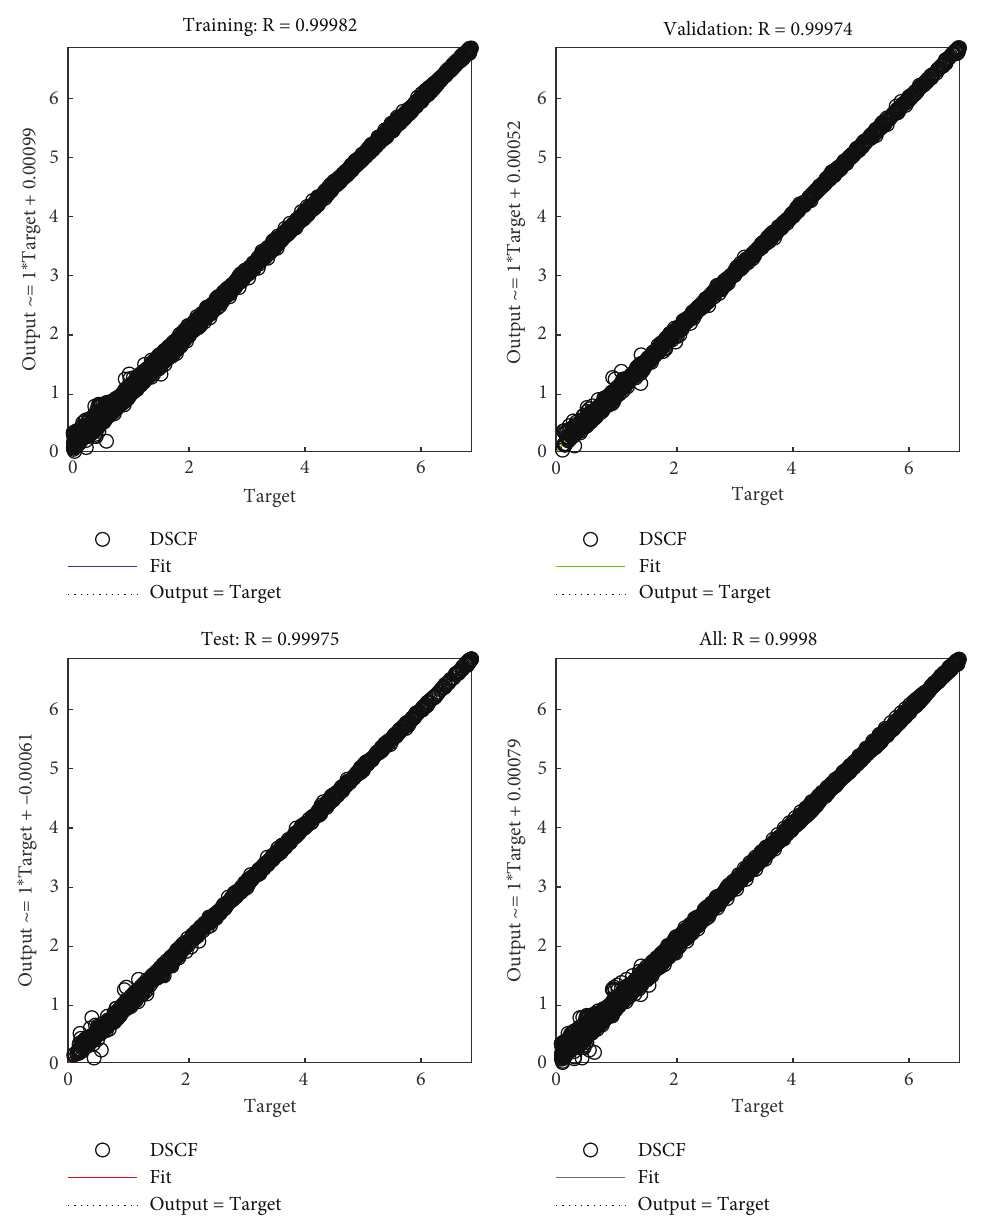
Figure 15: Regression coe ffi